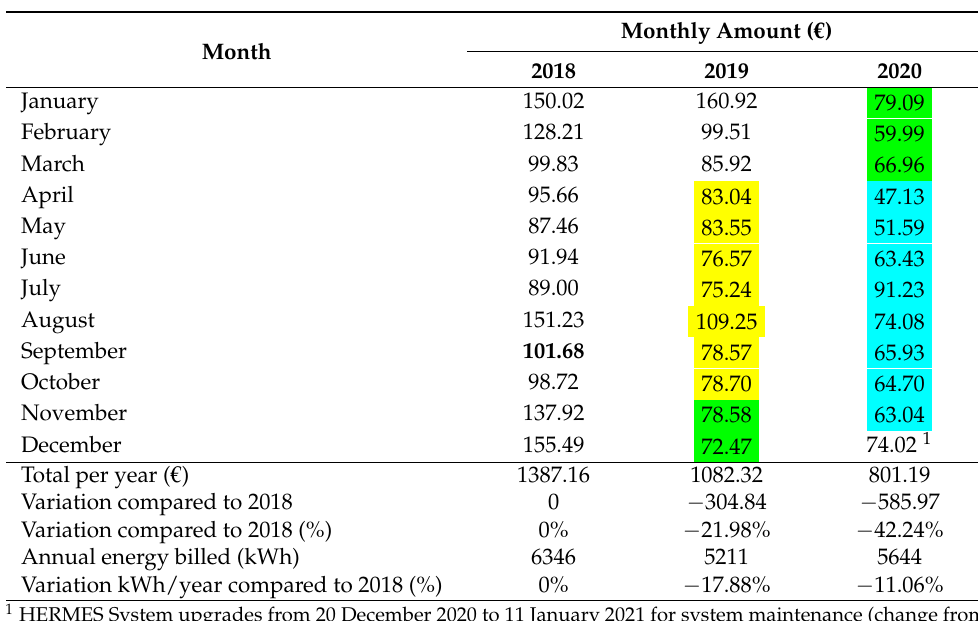
Table 7. Monthly energy billed: previous period P0; first period P1 (yellow); second period P2 (green); third period P3 (blue). Table 8. Monthly bill: previous period P0; first period P1 (yellow); second period P2 (green); third period P3 (blue).